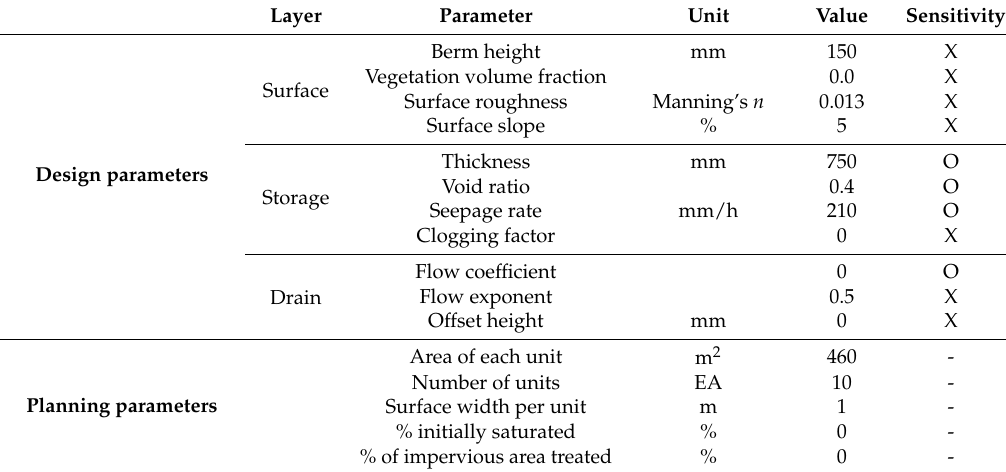
Table 2. Applied design and planning parameters for infiltration trench.